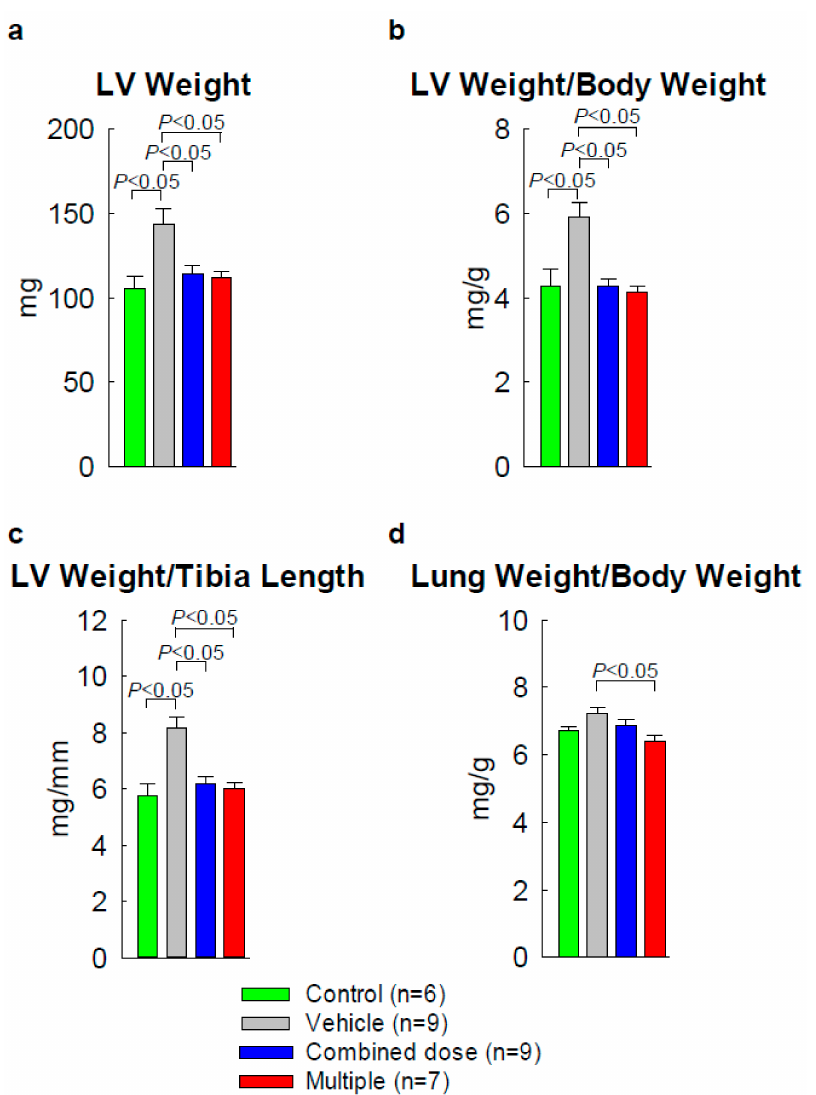
Figure 1. Assessment of left ventricular (LV) hypertrophy. LV weight, LV weight/body weight ratio, LV weight/tibia length ratio, and lung weight/body weight ratio. p < 0.05 shows statistical significance between the compared two groups. Data are means ±